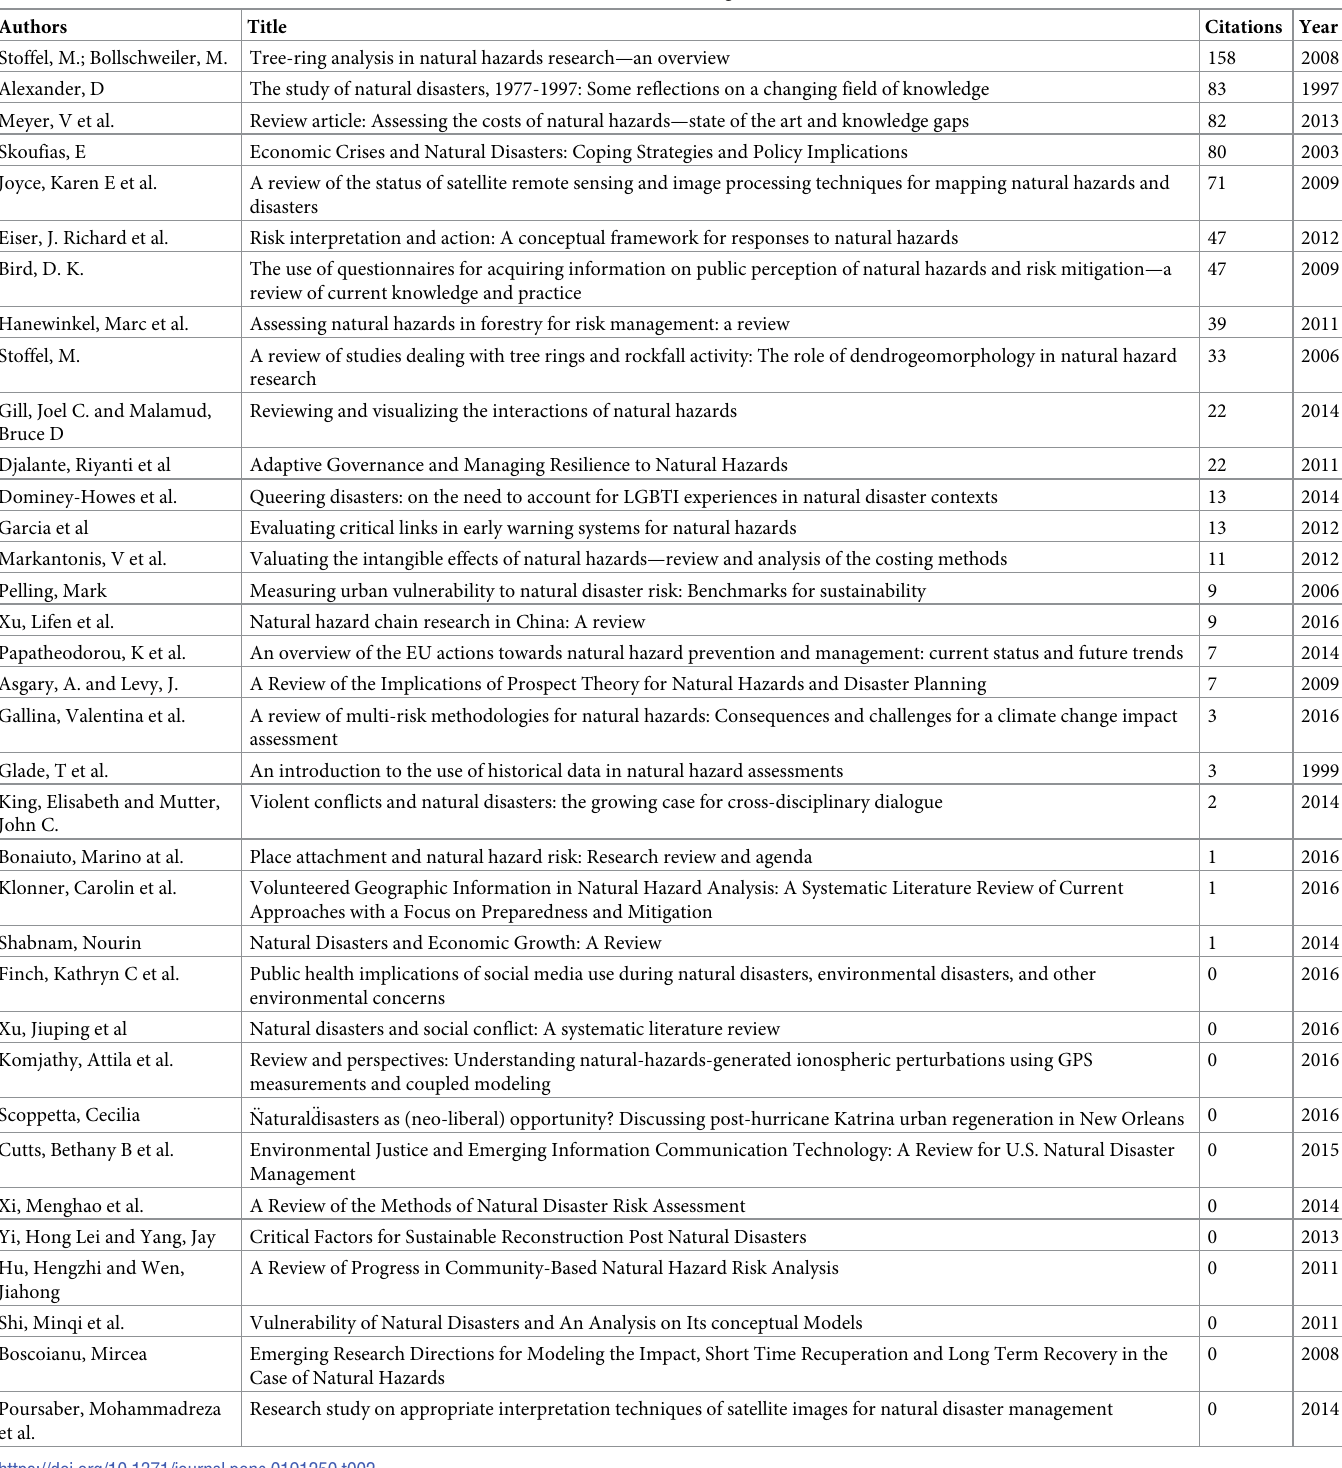
Table 2. Review articles on natural disasters research and their citations (with descending